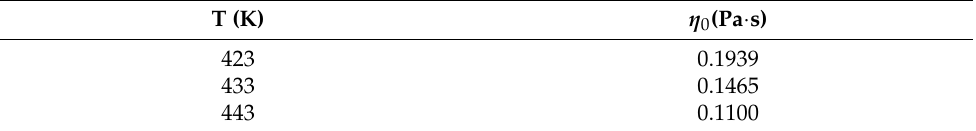
Figure 15. Viscosity changes with the temperature of the H 6 XDI/BES system. Table 4. η 0 values of the H 6 XDI/BES system at different temperatures. T (K)